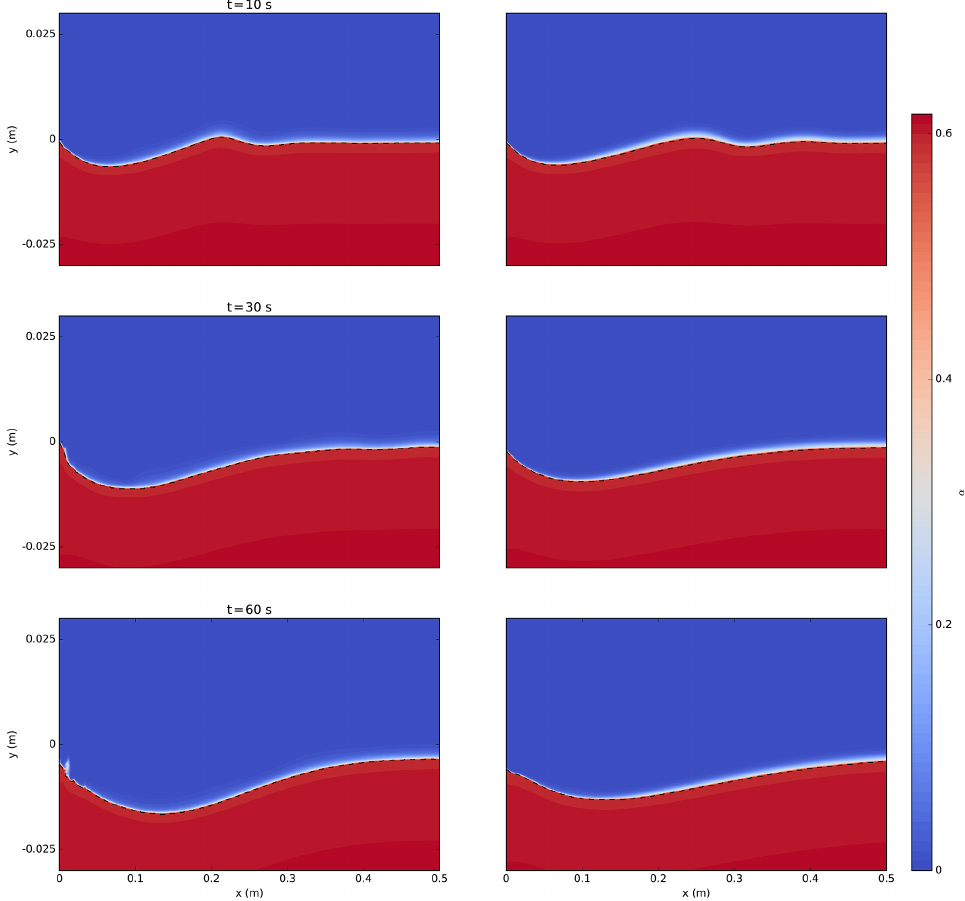
Figure 6. Sediment concentration contour at different times during the scour process using k − ε and kinetic theory (left column of panels) and k − ω and µ(I) granular rheology (right column of